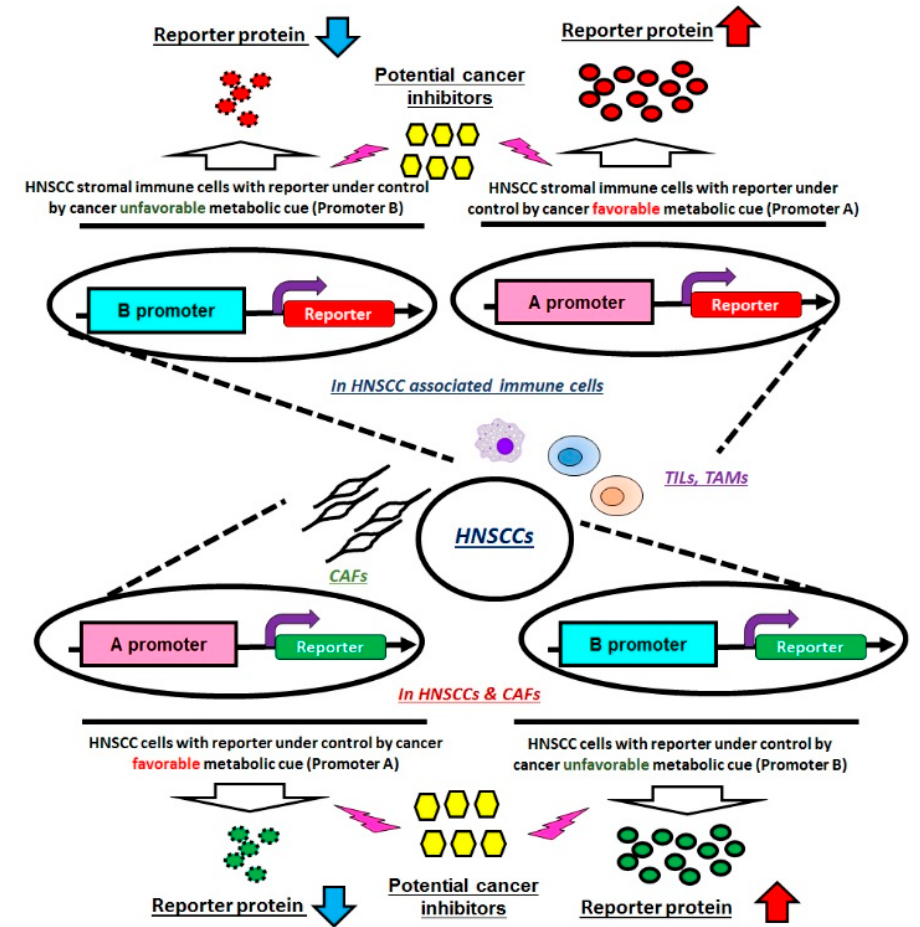
Figure 3. The hypothetic experimental design for novel metabolism-mediated anti-cancer drug screening. HNSCC and CAF cells containing reporters driven under a cancer favorable gene promoter (A promoter) and cancer unfavorable gene promoter (B promoter) could be established, while the same plasmid cassettes could also be introduced into tumor-associated immune cells. The system could be then utilized to screen potential cancer inhibitors via the detection of reporter alterations. CAFs: Cancer associated fibroblasts; TILs: Tumor infiltrating lymphocytes; and TAMs: Tumor associated macrophages.